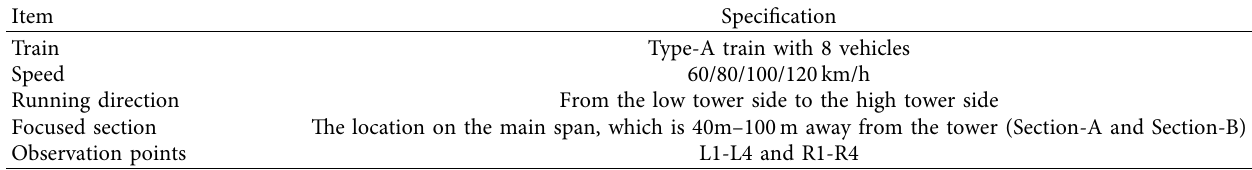
Table 2: Calculation conditions.